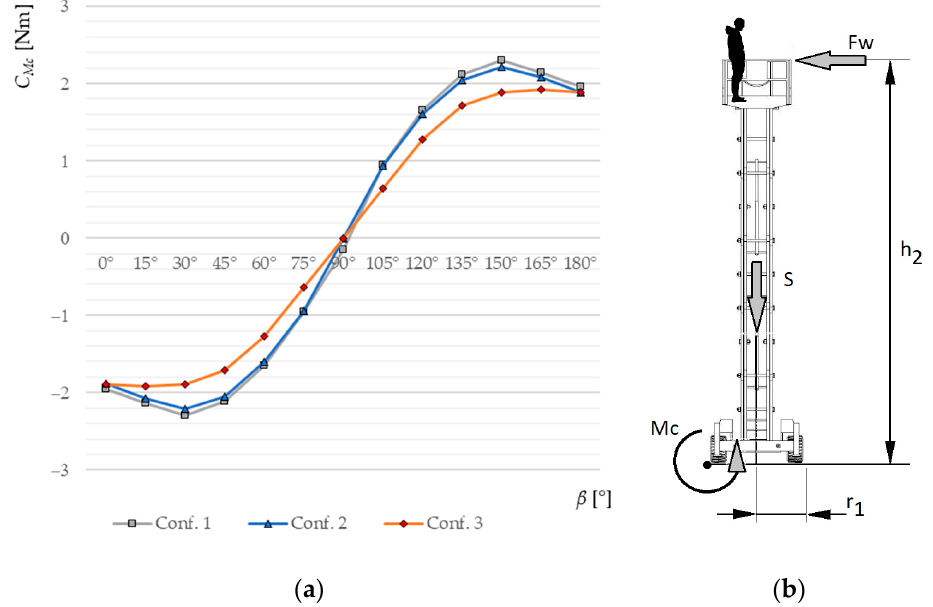
Figure 18. Calculation based on the CFD ( a ) the moment coefficient C Mc as a function of the wind direction described by angle β , ( b ) the schema of the loads acting on the investigated scissor lift. As can be observed, the most dangerous situation is when the wind blows along the direction, which creates the angle β = 30 ◦ with the X -axis of the coordinate system shown in Figure 3 for configurations 1st and 2nd. In the case of configuration 3rd, the most dangerous wind direction is equal to β = 15 ◦ . It is worth noting that the extended movable deck has no significant impact on the moment M induced by the wind. The maximal values of the coefficients are as follows C 1 Mc = 2.299, C 2 Mc = 2.212, and C 3 Mc = 1.920 for configurations 1st, 2nd, and 3rd,